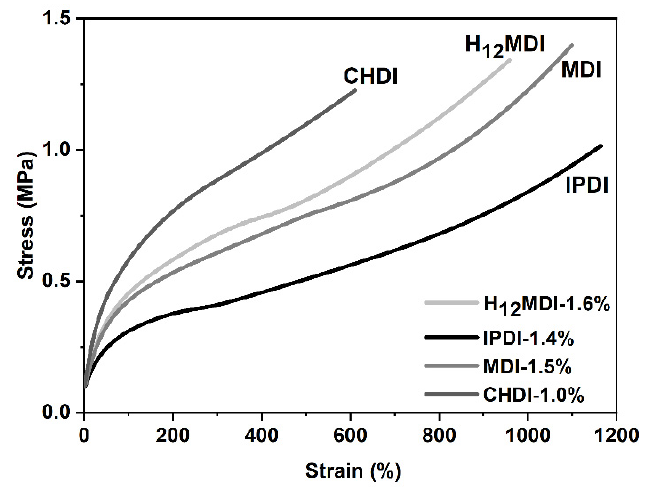
Figure 10. Representative stress–strain curves of PSU copolymers synthesized from the aliphatic diisocyanates H 12 MDI, IPDI, and CHDI and the aromatic diisocyanate MDI without chain extenders. The YM is highest for the CHDI-based copolymer, as is apparent from the steep increase of stress within the linear range of the stress–strain curves. The stress–strain curves of the copolymers based on H 12 MDI and MDI present approximately equal slopes and exhibit elongations of more than 800%. The lowest YM value is presented by the curve of the IPDI-based copolymer.